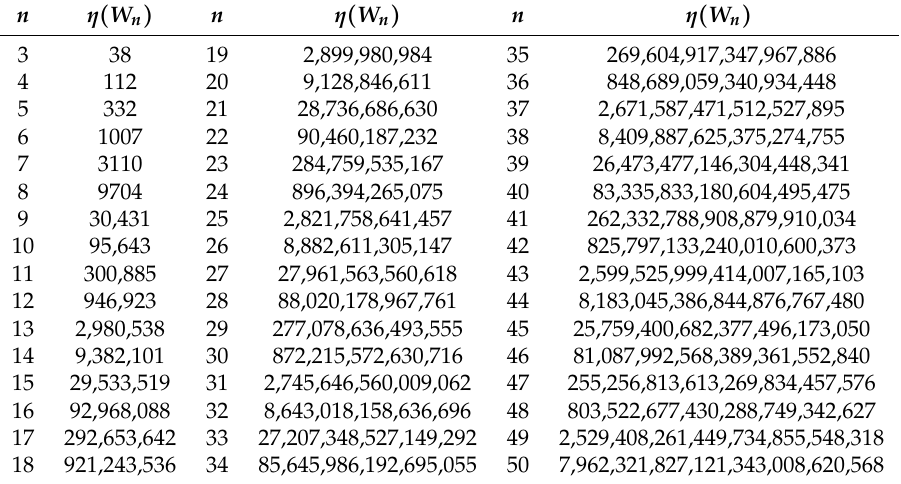
Table 1. The subtree numbers of wheel graph W n ( n = 3,4, . . .